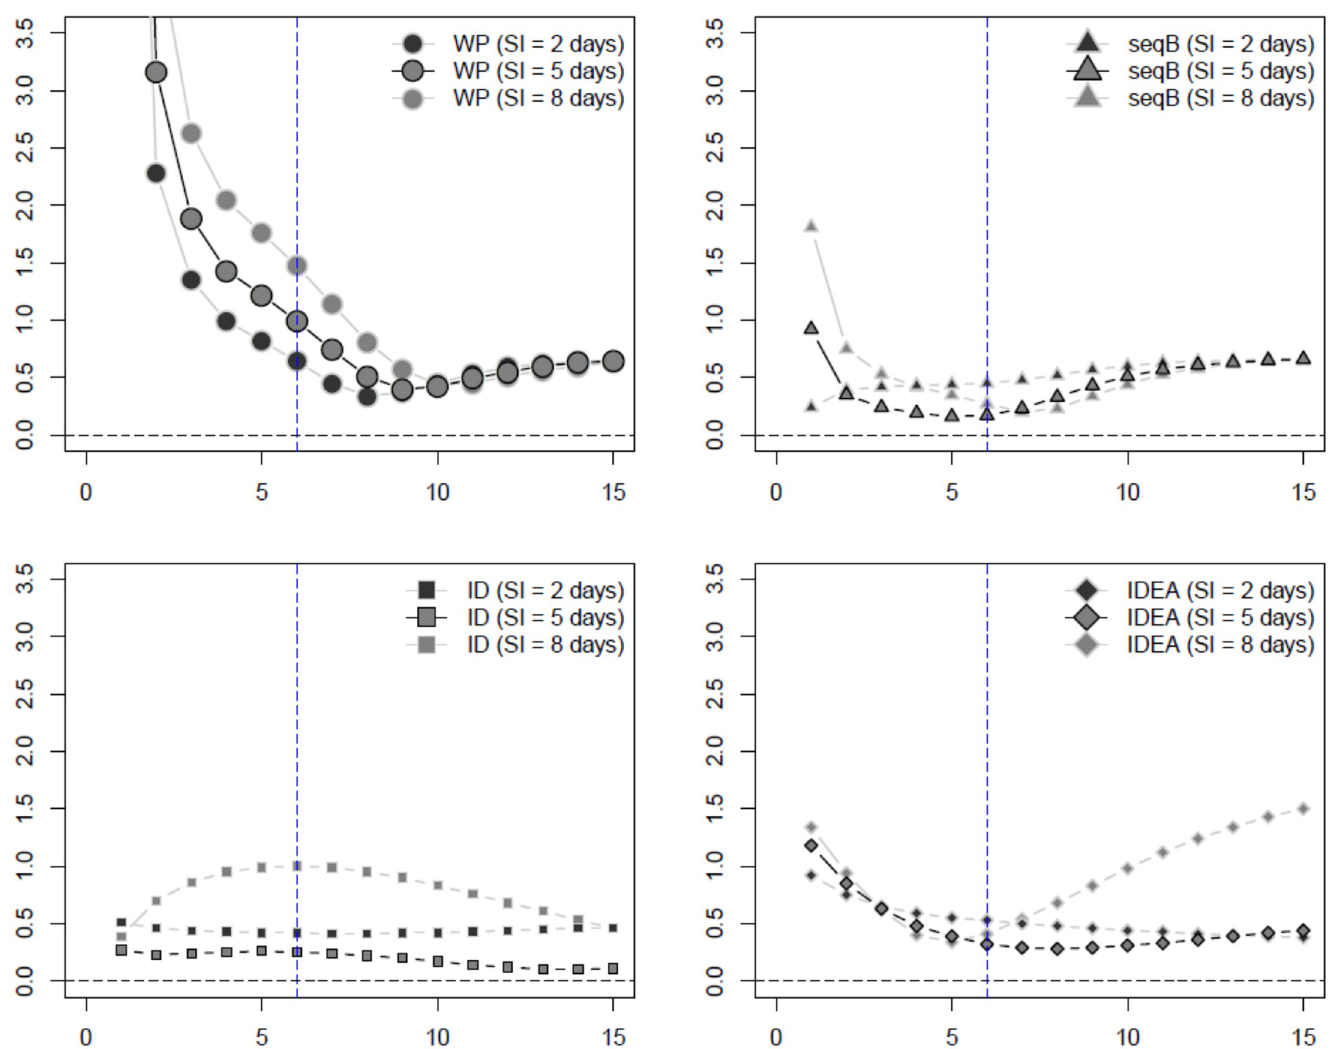
Fig 3. Influenza example 2 estimated MSE of R 0 estimators assuming known serial interval (SI) with SIR data (week on x -axis). The inflection point indicated by the blue dashed vertical line.